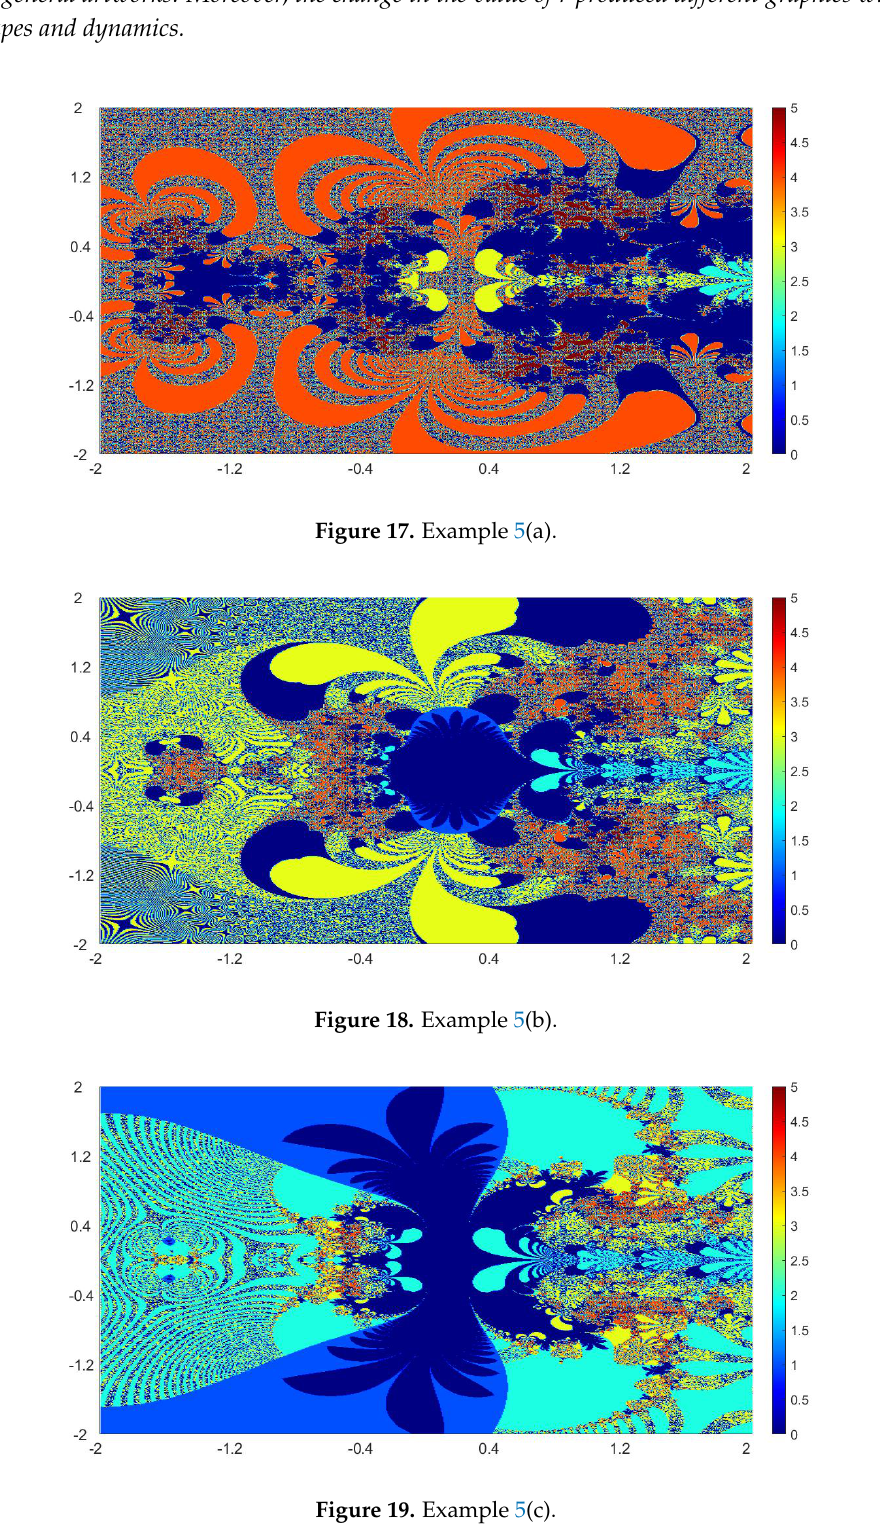
Figure 19. Example